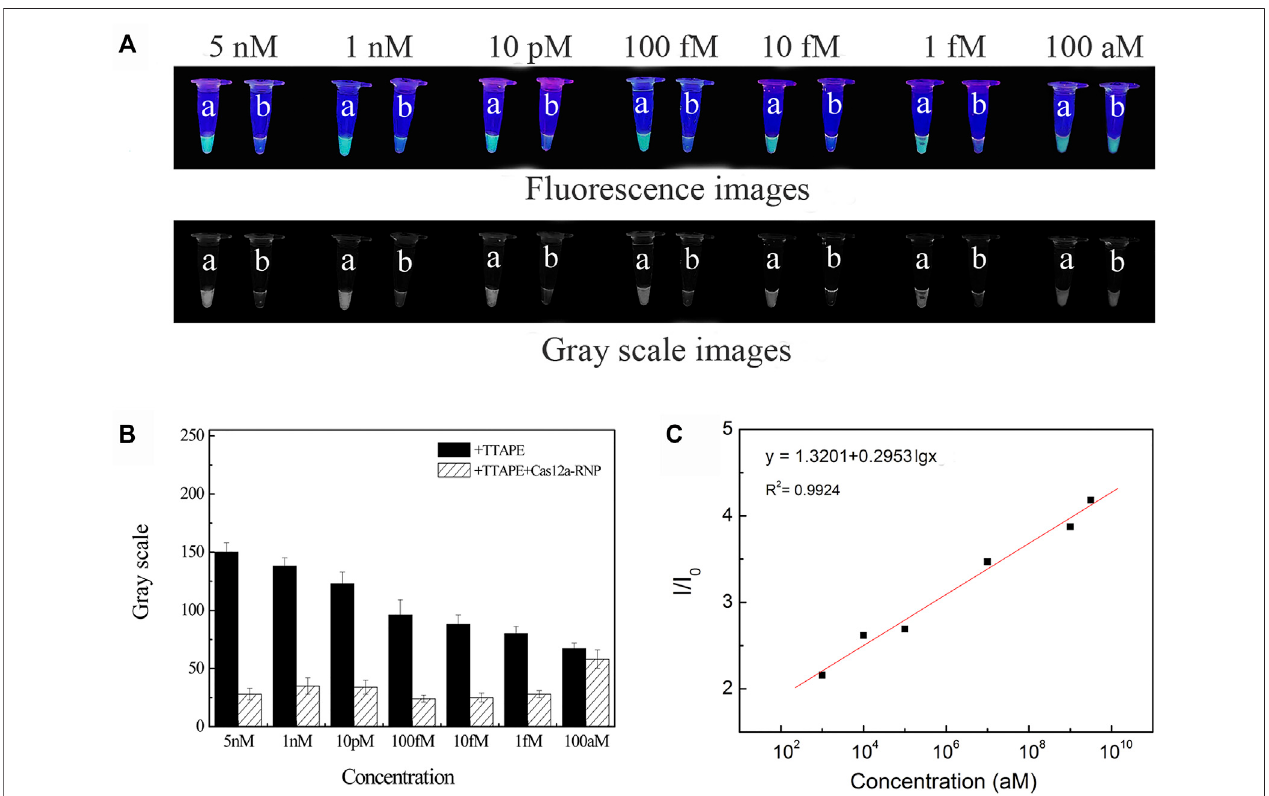
FIGURE 3 | (A) The visual discrimination results under UV irradiation and gray scale images of L. pneumophila at different concentrations (a: +TTAPE, b: +TTAPE +Cas12a-RNP); (B) Grayvalueof L.pneumophila atdifferentconcentrations(thegrayvalueisobtainedbyanalyzingthegrayimagebyimageJ). (C) Linearrelationshipof the fl uorescence (I/I 0 ) and logarithm concentration of L. pneumophila